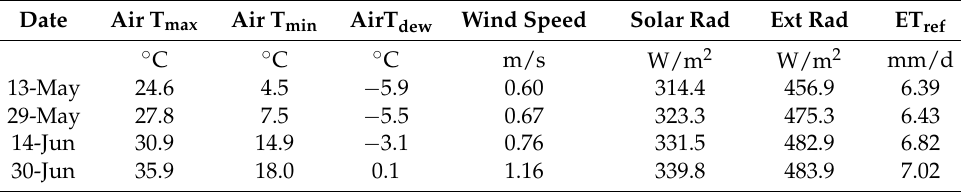
Table 6. Daily Weather Information for Landsat overpass